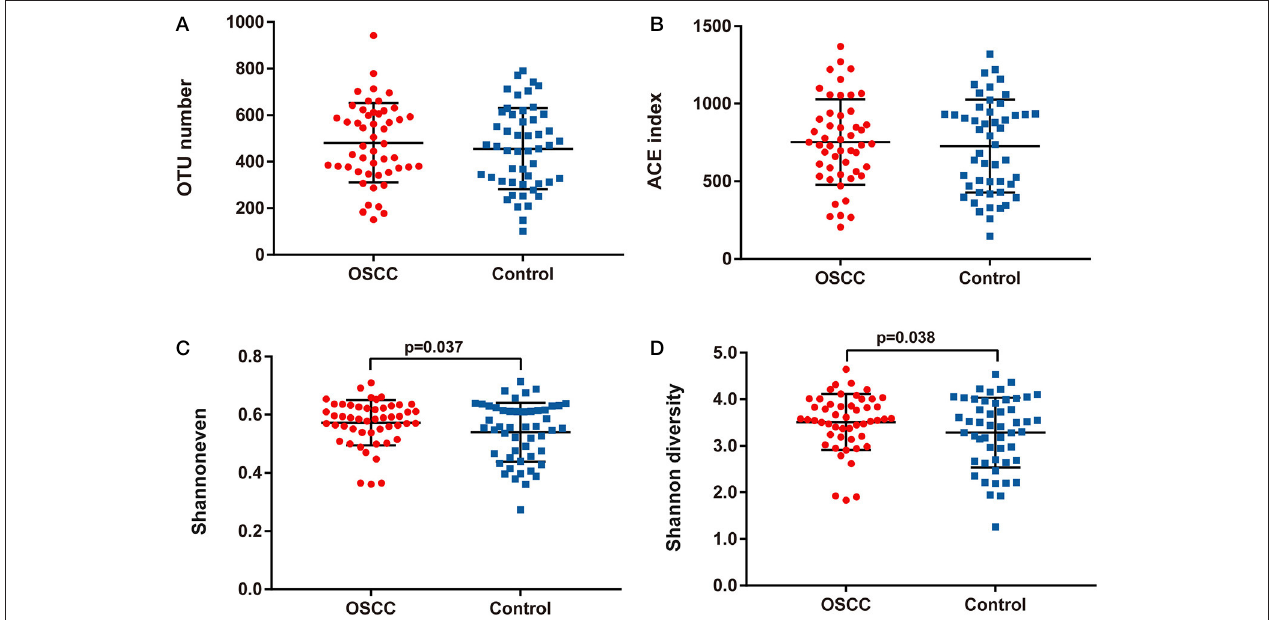
FIGURE 1 | Comparison of bacterial richness, evenness and diversity between OSCC and Control groups. (A) OTU number, (B) ACE index, (C) Shannon even index and (D) Shannon diversity index.